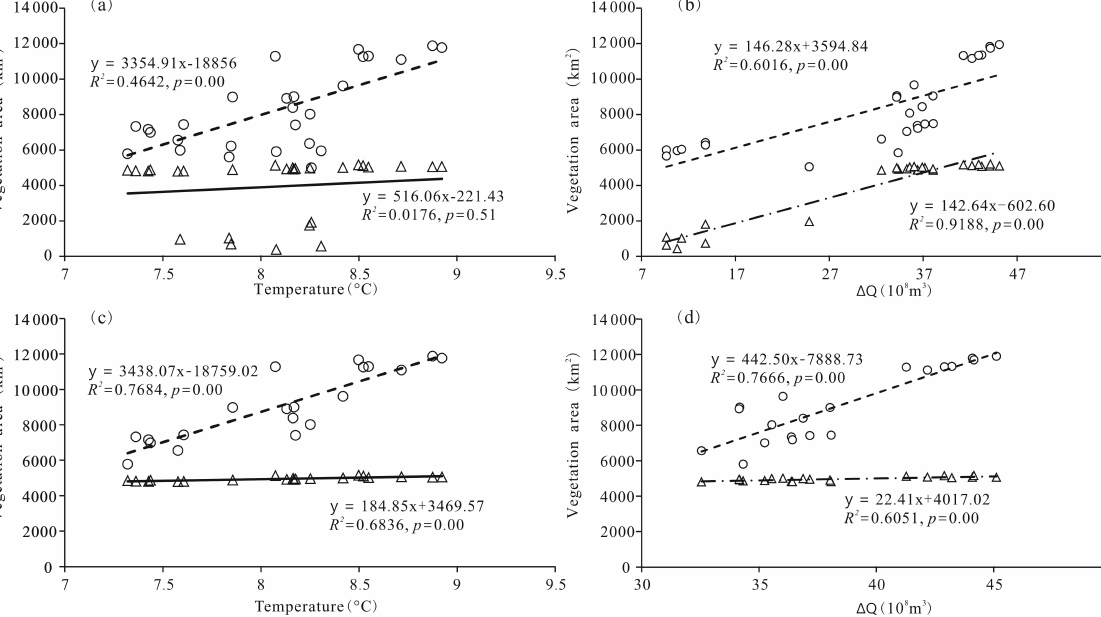
Figure 7. Correlation between vegetation (circle: natural vegetation; triangle: crops) and T (a, c) and (cid:49)Q (b, d) . (a) and (b) presented all reconstructed data for the past 2000 years; (c) and (d) only used Landsat-derived